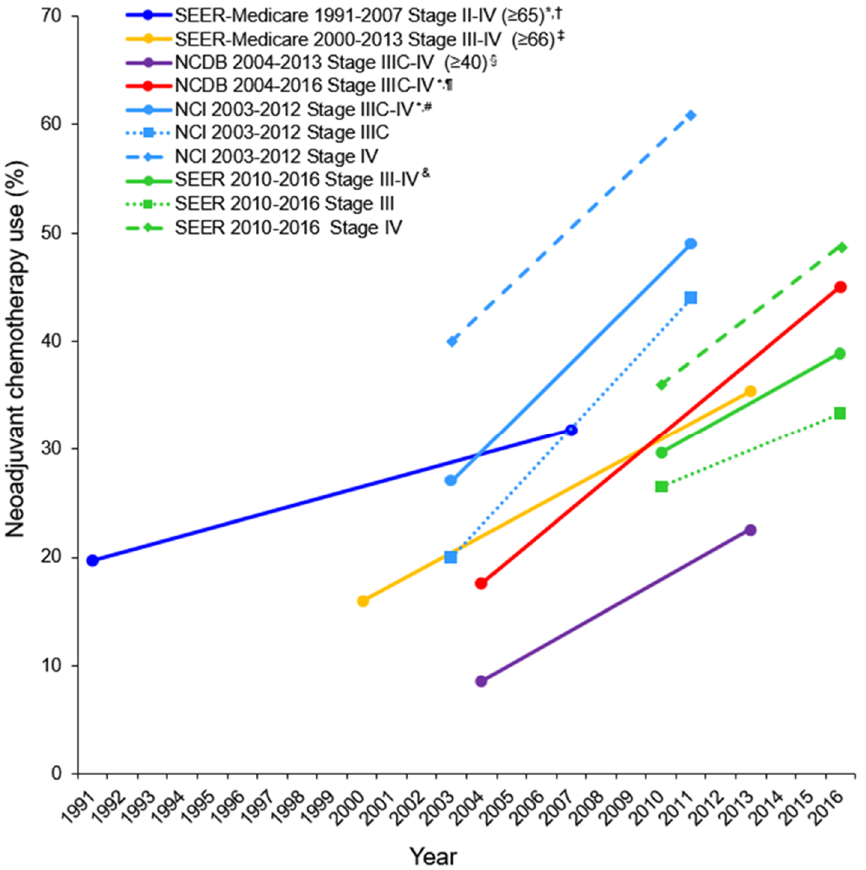
Figure 1. Trends of neoadjuvant chemotherapy use for advanced ovarian cancer in major U.S. observational studies. Adopted and modified from the author’s own work [11]: Gynecol. Oncol. 2021 , 160 , 32–39. Matsuo, K., et al. Possible candidate population for neoadjuvant chemotherapy in women with advanced ovarian cancer. Trends in the use of neoadjuvant chemotherapy for advanced ovarian cancer in U.S. observational studies. Copyright (2021) with permission from Elsevier. Proportion of NACT with ovarian cancer per calendar year is shown. Only starting point and end point are shown. Y-axis is truncated to 0–70%. * In the trend analysis, neoadjuvant chemotherapy without surgery was included † [8]. ‡ [9]. § [6]. ¶ [7]. # [10]. & [11]. Abbreviations: NCDB, National Cancer Database; and SEER, The Surveillance, Epidemiology and End Results; NCI, National Cancer Institute; U.S., United States of America.